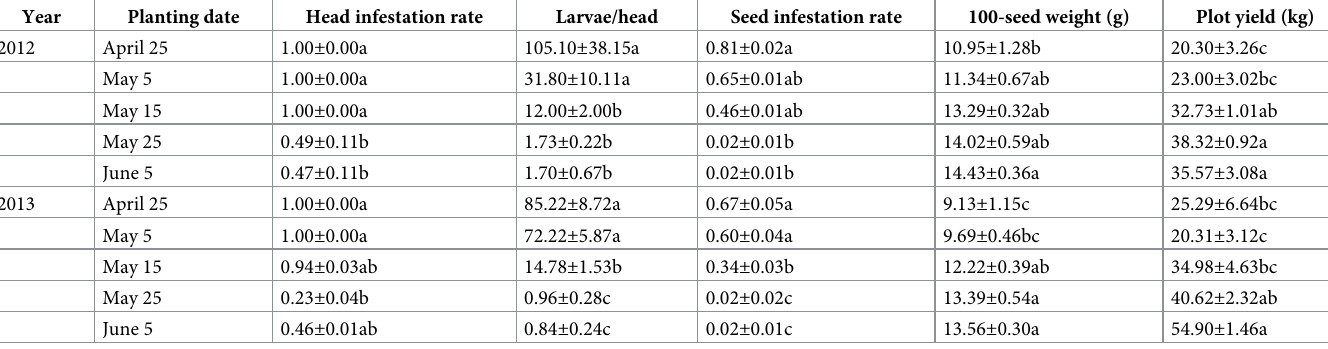
Table 1. Effects of sunflower planting date on measures of infestation by H . nebulellum .